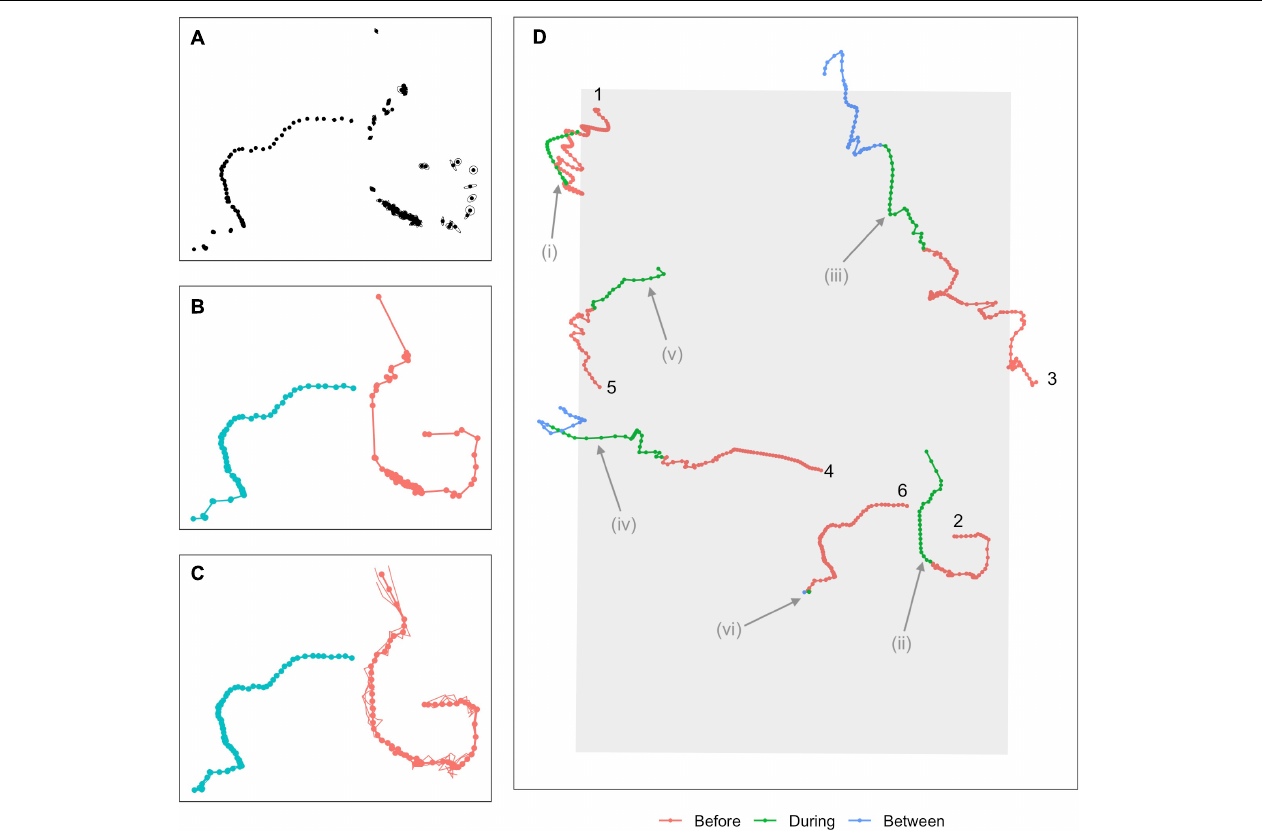
FIGURE 2 | Overview of modeling process. (A) Calls are first detected and localized, with associated measurement errors indicated by ellipses around each point. (B) An association algorithm groups localizations into tracks. (C) A continuous-time movement model is fitted to the tracks, allowing locations and associated location errors to be estimated at any time. Points show estimated mean locations at 5-min intervals (“single imputation”), connected by linear interpolation (thicker solid line). Thinner lines show three simulated plausible trajectories for each animal (“multiple imputation,” points for these tracks suppressed for clarity). (D) A subset of six single-imputation tracks overlapping with the During sonar exposure phase, some of which demonstrate potential avoidance behavior. Colors indicate sonar exposure phase and a track ID number is used to indicate the beginning of the track. Potential avoidance responses include changes in headings (Tracks 1, 2, 3; possible changes indicated at i, ii, iii), increased speed (Tracks 4, 5; indicated at iv, v), more directional movement (Track 3, at iii), or cessation of calling (Track 6, at vi). Evidence of avoidance can be fairly clear (Tracks 1 and 2) but is often ambiguous or inconclusive (Tracks